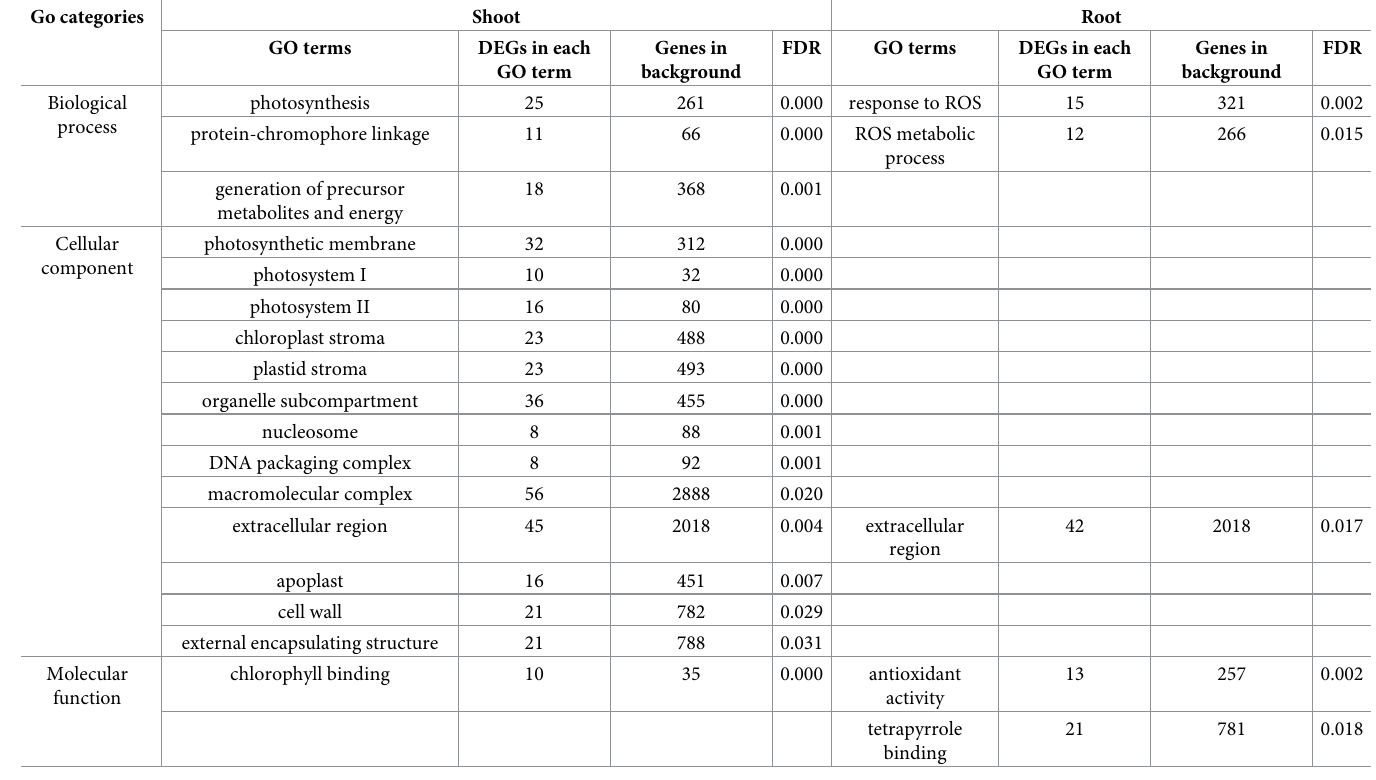
Table 3. Functional category annotations of downregulated genes in both rice genotypes. Go